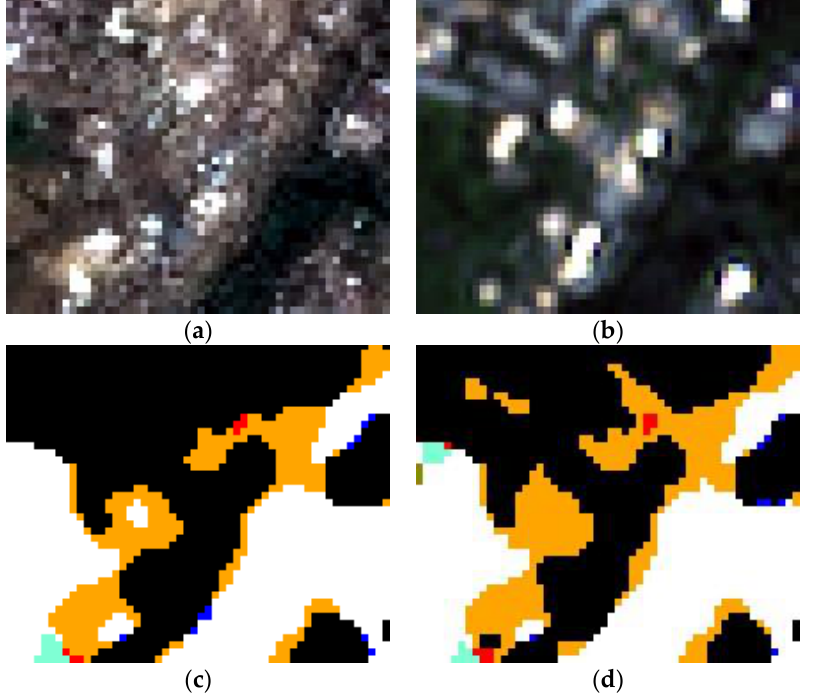
Figure 15. Results obtained with and without SAR data: ( a ) RGB composition of an optical crop acquired in 2016 (image © CNES 2017–2018, distribution Airbus DS); ( b ) RGB composition of an optical crop acquired in 2017 (image © CNES 2017–2018, distribution Airbus DS); ( c ) change map obtained without using the COSMO-SkyMed data and corresponding to the timeframe 2016–2017; ( d ) change map obtained using the COSMO-SkyMed data and corresponding to the timeframe 2016–2017. The legend is the one provided in Figure